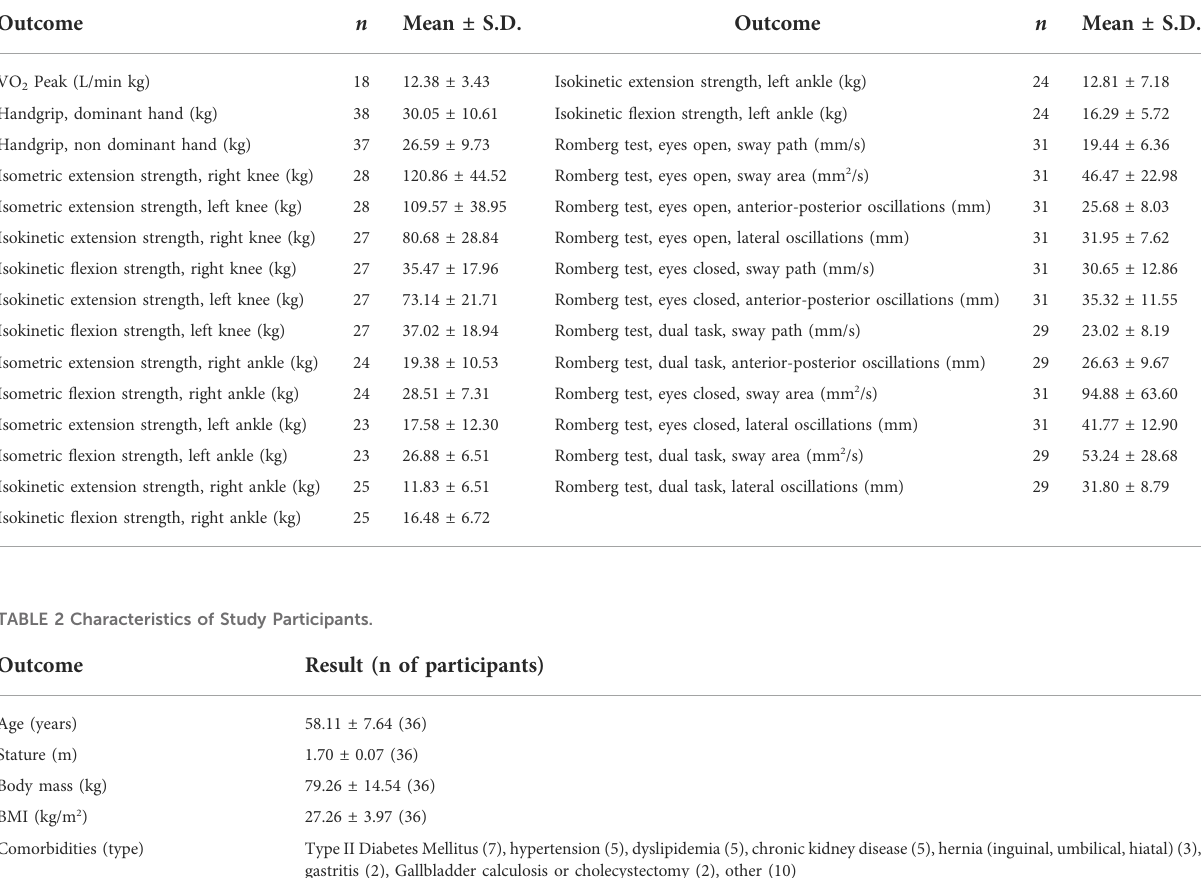
TABLE 1 Test Results.